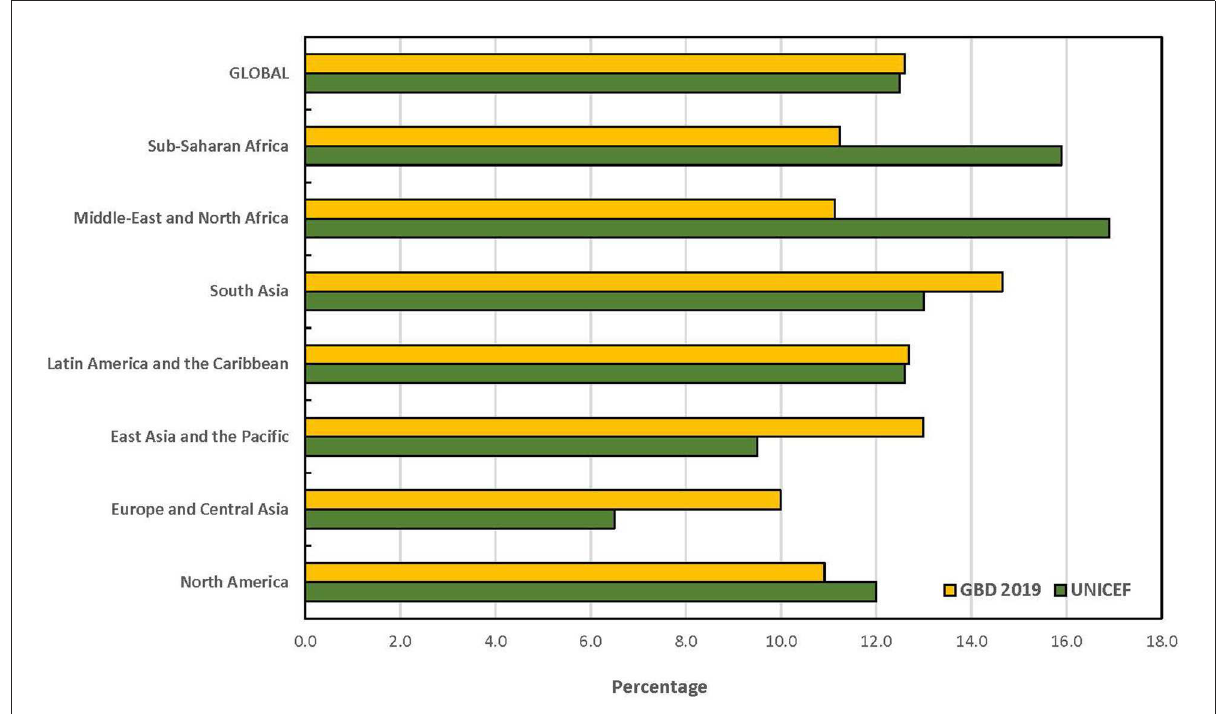
FIGURE2 Prevalence estimates of disabilities among children aged 5 to 19 years by UNICEF and GBD